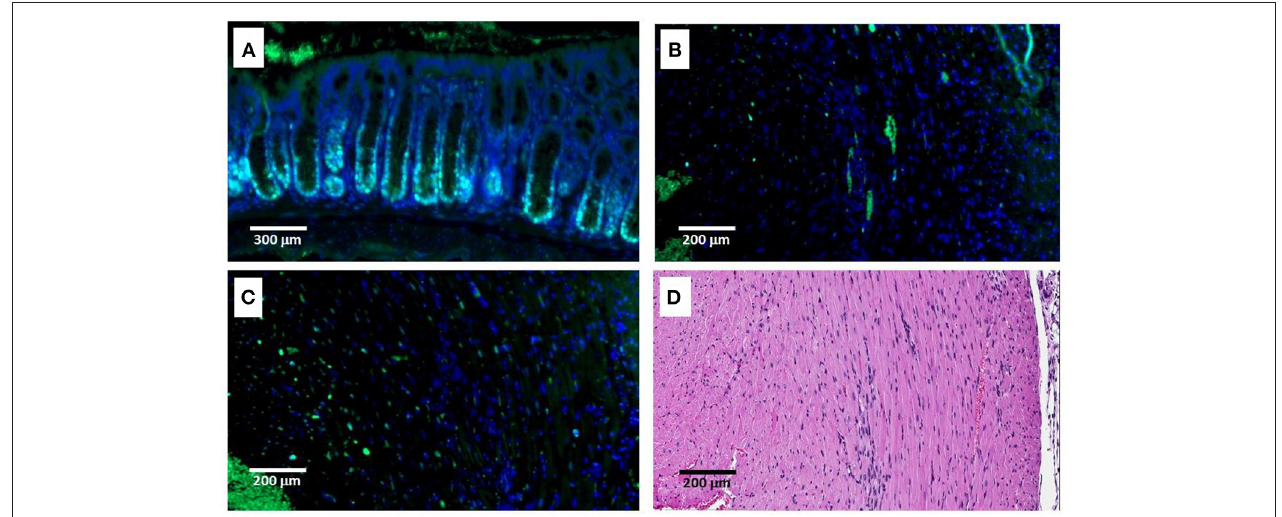
FIGURE 7 | Immunofluorescence staining (IF) of proliferating cells by anti-PCNA antibody on Day 9 post-MI and intramyocardial α -gal nanoparticles injection. (A) Intestinal villi demonstrating multiple proliferating cells with stained nuclei at the base of the crypts. (B,C) IF staining of the LV by anti-PCNA antibody. Only small number of stained nuclei is observed. (D) H&E staining of the LV presented in (B,C) . Data from one mouse of 5 with similar